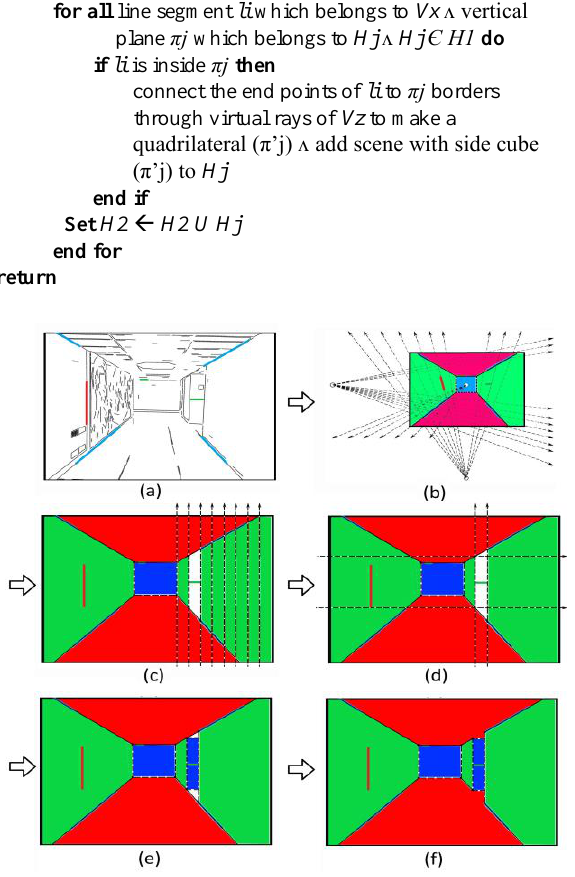
Figure 2. Creating Layout hypothesis; a) Line segments are randomly selected. b) Key cube generation by intersecting line segments (solid lines) and created virtual rays (dashed lines) using vanishing points. c) Virtual rays partitions the vertical plane. d) More partitioning using virtual rays. e) Identifying the plane facing the camera (blue plane). f) Identifying floor and ceiling regions in the created partition (white triangles in